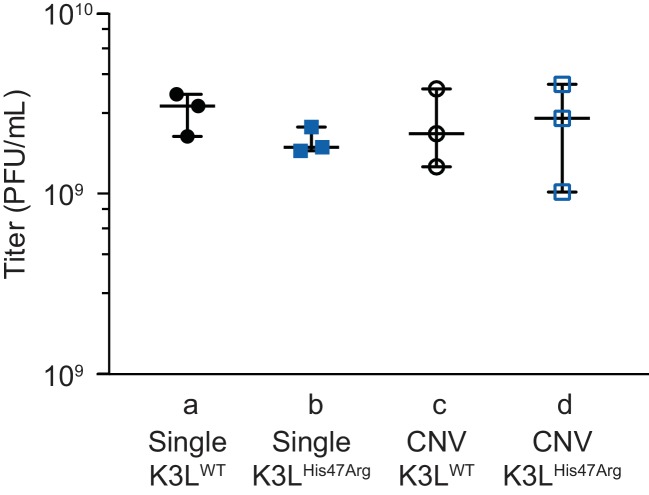
K3LHis47Arg and K3L CNV are non-adaptive in the permissive BHK cell line.Replication was measured for plaque purified clones (as in Figure 1D) in BHK cells by 48 hr infection (MOI 0.1) in triplicate. All titers were measured multiple times in BHK cells by plaque assay, shown with median and 95% confidence intervals. Statistical analysis was performed to compare the means of populations b or c relative to a, or between the means of populations b or c relative to d by one-way ANOVA followed by Dunnett’s multiple comparison test. No significant differences were observed between any of the compared populations.10.7554/eLife.35453.009Figure 1—figure supplement 1—source data 1.Data used to generate Figure 1—figure supplement 1.10.7554/eLife.35453.010Figure 1—figure supplement 1—source data 2.Statistics for Figure 1—figure supplement 1, One-way ANOVA followed by Dunnett’s multiple comparison test.